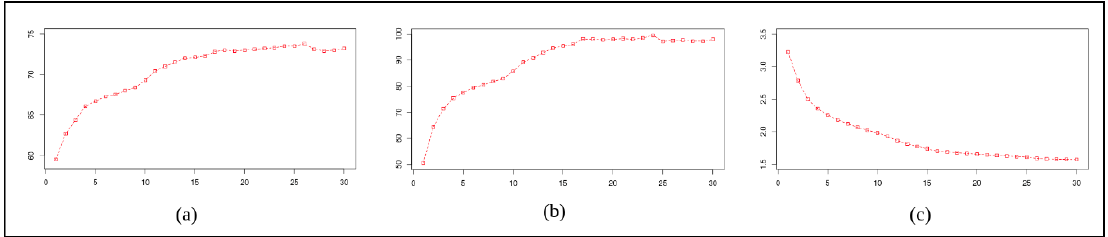
Figure 6. The progression of scores and cross entropy loss improvement along the epochs: ( a ) the BLEU-1 evaluation score, starting from 59.5 in Epoch 1 and peaking at 73.6 in Epoch 26 before it stop improving; ( b ) the CIDEr evaluation score, starting from 50.6 in Epoch 1 and peaking at 99.6 in Epoch 24 before no longer improving; and ( c ) the cross entropy loss of our model across the epoch.